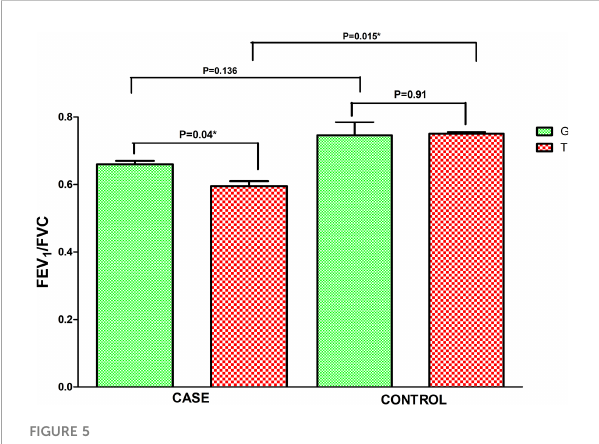
FIGURE 5 Level of FEV1/FVC ratio in asthmatic patients bearing different alleles of TBXA2R rs34377097 polymorphism. Comparison between cases and controls was performed by Independent t test. (*P value signi fi cant).